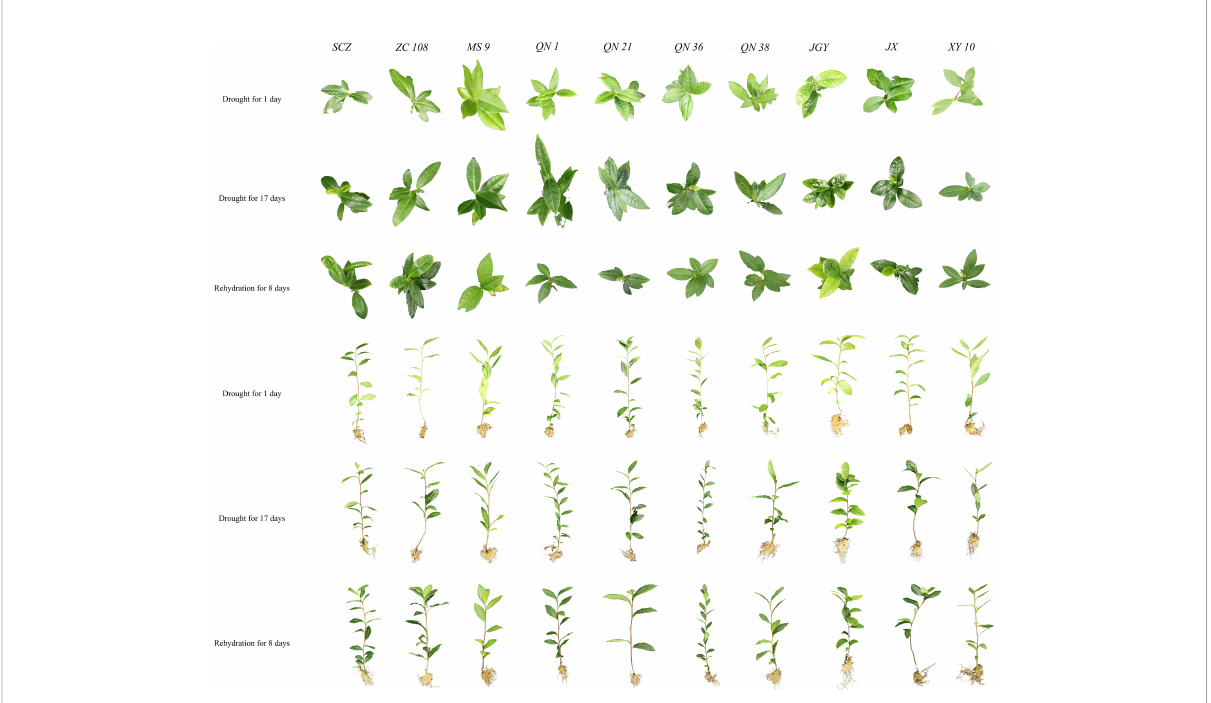
FIGURE 6 Phenotypic changes of ten tea germplasm resources in three experimental stages (drought for 1day, drought for17days and rehydration for